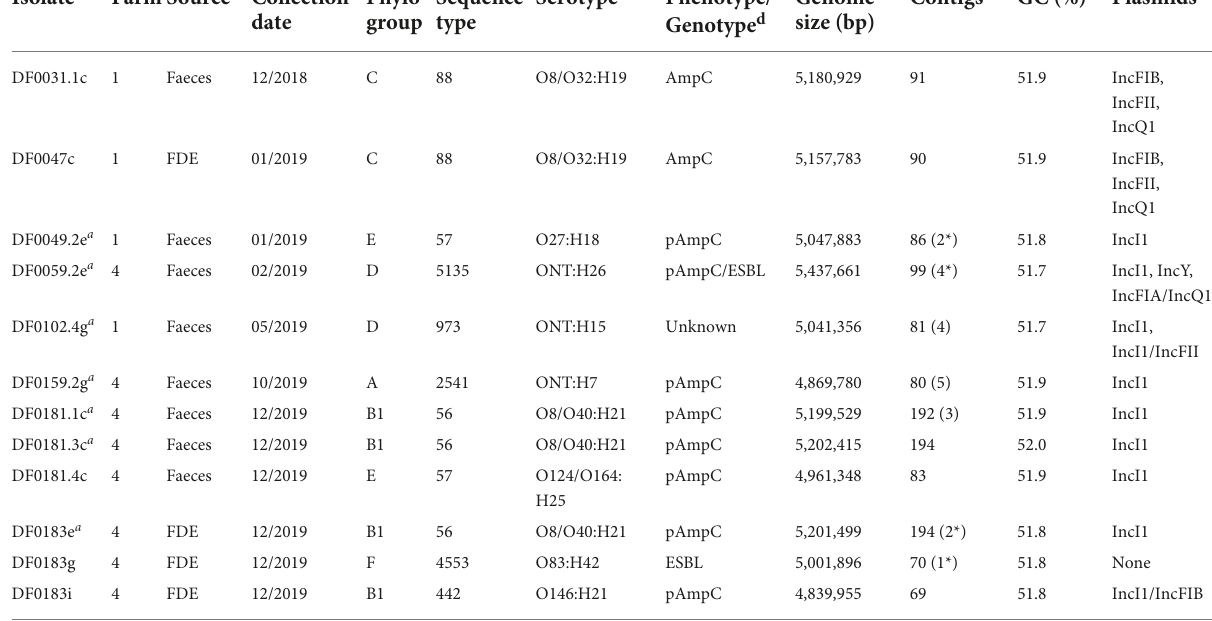
TABLE 3 Genome composition of E. coli ( n = 12) sequenced in this study. Isolate a Farm Source b